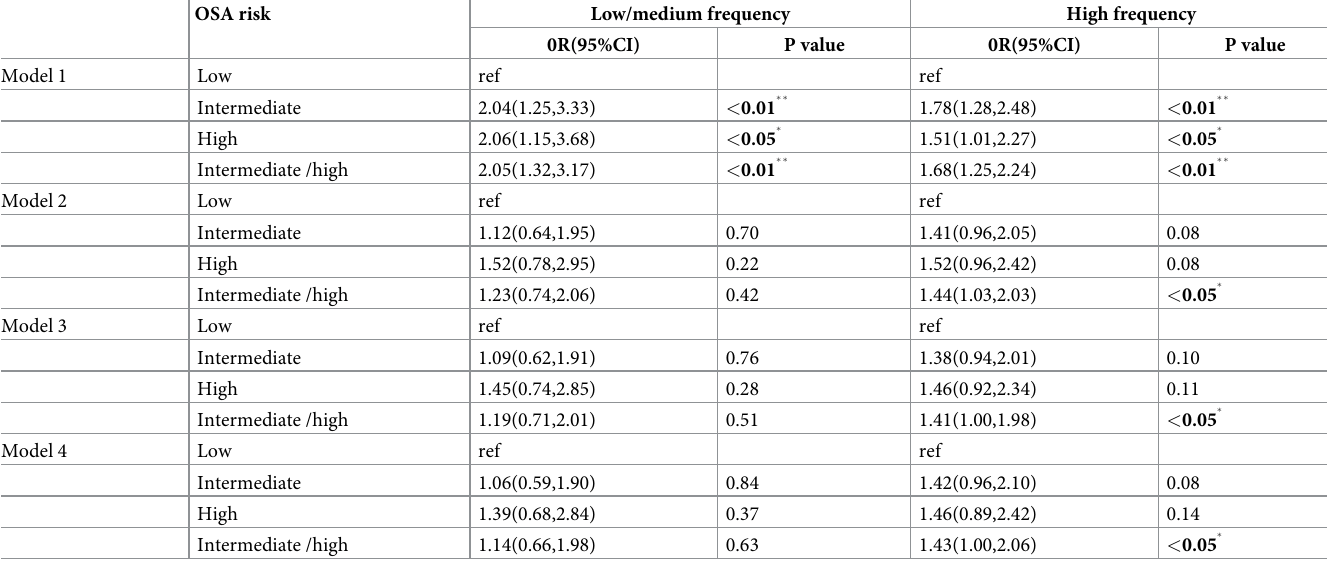
Table 4. Multivariable models comparing the risk of pure-tone hearing fails in different frequency ranges grouped by OSA risk based on STOP-BANG scores.